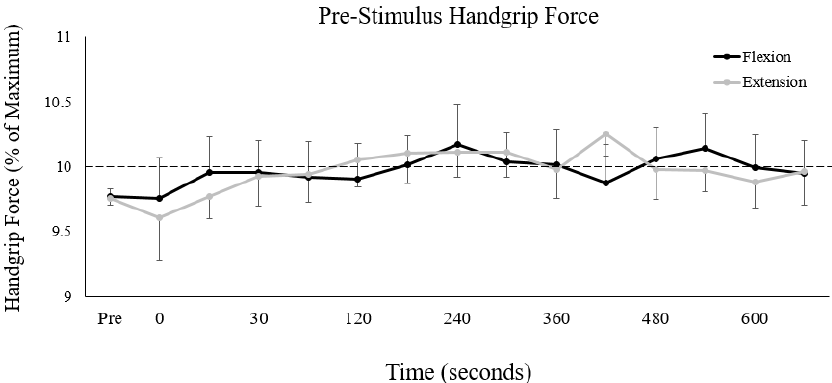
Figure 3. Group averages of pre-stimulus (50 ms) handgrip force immediately prior to TMS. Black / grey lines represent pre-stimulus handgrip force during the flexion / extension fatigue sessions, respectively. The y -axis is scaled to the total target range allotted to participants (10 ± 1% of maximal handgrip force). The dashed horizontal line represents the 10% target participants were instructed to match. The x -axis displays time of measurement, with “pre” representing the non-fatigued baseline measures and “0” representing the first measurement immediately after the cessation of the fatigue-inducing trial. All unlabeled points occurred 15 s after the preceding time point. Error bars represent standard error.